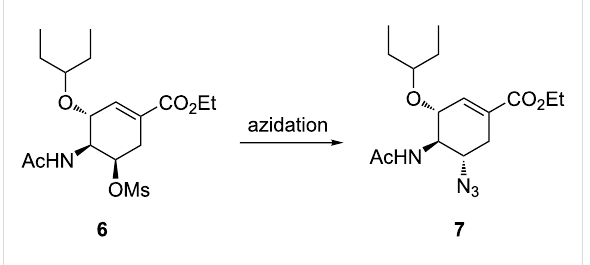
cessfully developed. NaN 3 (aq) is the best azidating agent for mesyl shikimate 4 towards the desired azide 5 . The optimum conditions are 1.1 equivalents of NaN 3 , 50 °C and 12 s affording full conversion (HPLC) towards the desired azide 5 in 91% isolated yield. Unlike all literature procedures [9,19,20], side product 5a was not detected using our procedure at 50 °C and 12 s residence time. The use of green solvents, excellent selectivities, safe handling of potentially explosive intermedi- ates rendered the overall process green. The reported batch pro- cedures afforded azide 5 in 91–93% yield over an average of 3 h [9,19,20] which evidently makes our continuous flow proce- dure more superior. Our procedure could have benefited from the ‘fast and hot’ strategy, which is exclusive to flow chemistry technology. In this strategy, reagents are passed through a heated zone under high temperature at very fast flow rates allowing for rapid reaction completion and is out of the heated zone before significant byproduct is formed [25]. NaN 3 is the cheapest and greenest azidating reagent of all the developed procedures, however, the drawback is that it is not possible to integrate with the next step, but if this is the case then that strategy will have to be implemented. Basic reaction conditions and high temperatures promote the unwanted aromatisation reaction. There was no aromatisation detected when pure azide elimination and subsequent aromatisation of azide 5 at high temperatures. Our azidating procedures described herein are superior to the reported long batch procedures (2–4 h)